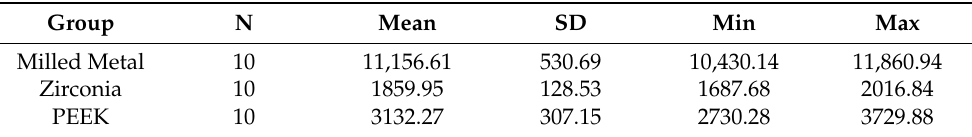
Table 1. Means, standard deviations (SD), maximum and minimum fracture load values (N) of all materials.